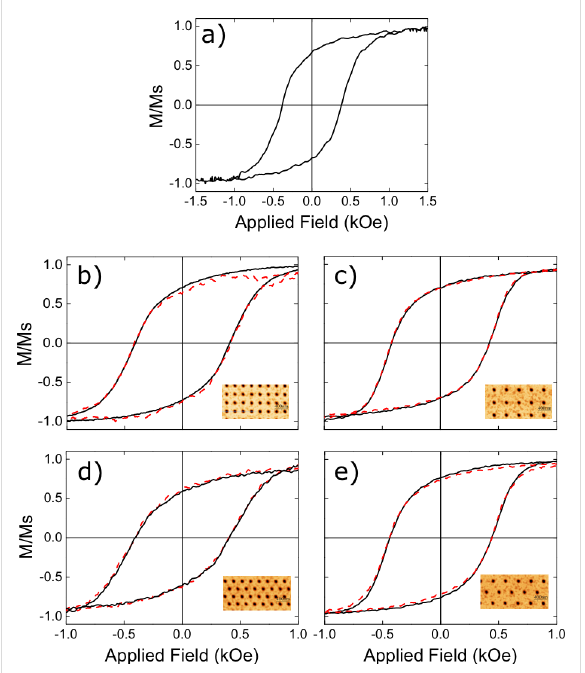
Figure 4: Central region of the hysteresis curves for the antidot arrays obtained from a 27 nm thick film. (a) Pristine thin film; (b, c) square arrays with lattice parameters of 240 and 360 nm, respectively; (d, e) hexagonal arrays with lattice parameters of 240 and 360 nm, re- spectively. Solid black lines correspond to a field applied in the direc- tion of first neighbors, while the red dashed lines to a field applied in the direction of the second